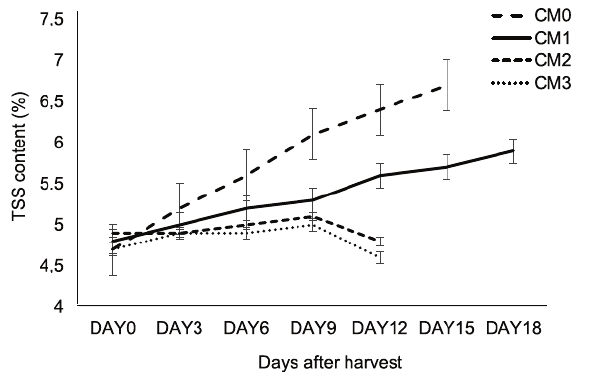
ge.Fig. Fig. 4 ­ Effect of cactus mucilage coating on iron content of bell pepper. Error bars indicate ±SE of the mean. CM0 is fruit coated with 0% cactus mucilage, CM1 is fruit coated with 1% cactus mucilage, CM2 is fruit coated with 2% cactus mucilage and CM3 is fruit coated with 3% cactus mucila­